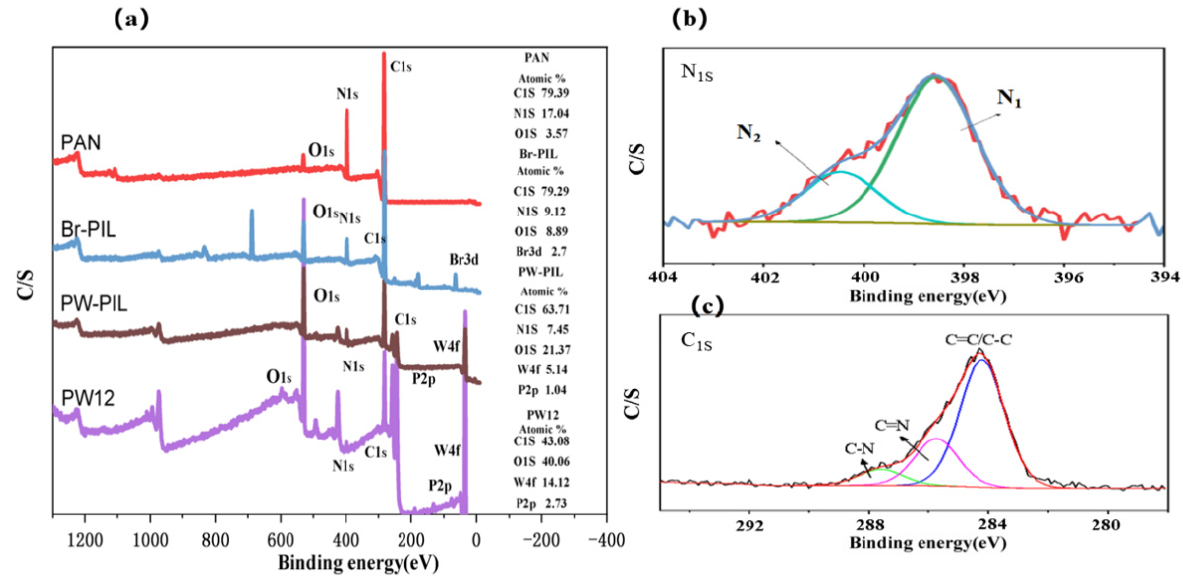
Figure 2. ( a ) XPS survey spectra of PAN, Br-PIL, PW-PIL and PW12; ( b ) high-resolution XPS spectra of N 1s in PW-PIL; ( c ) high-resolution XPS spectra of C 1s in PW-PIL.